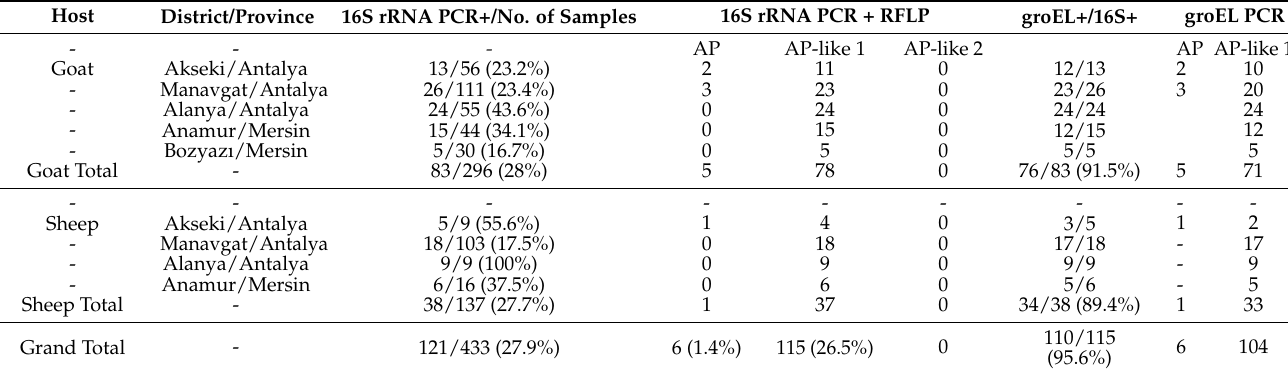
Table 2. Samples origin, 16S rRNA PCR, RFLP and groEL PCR.